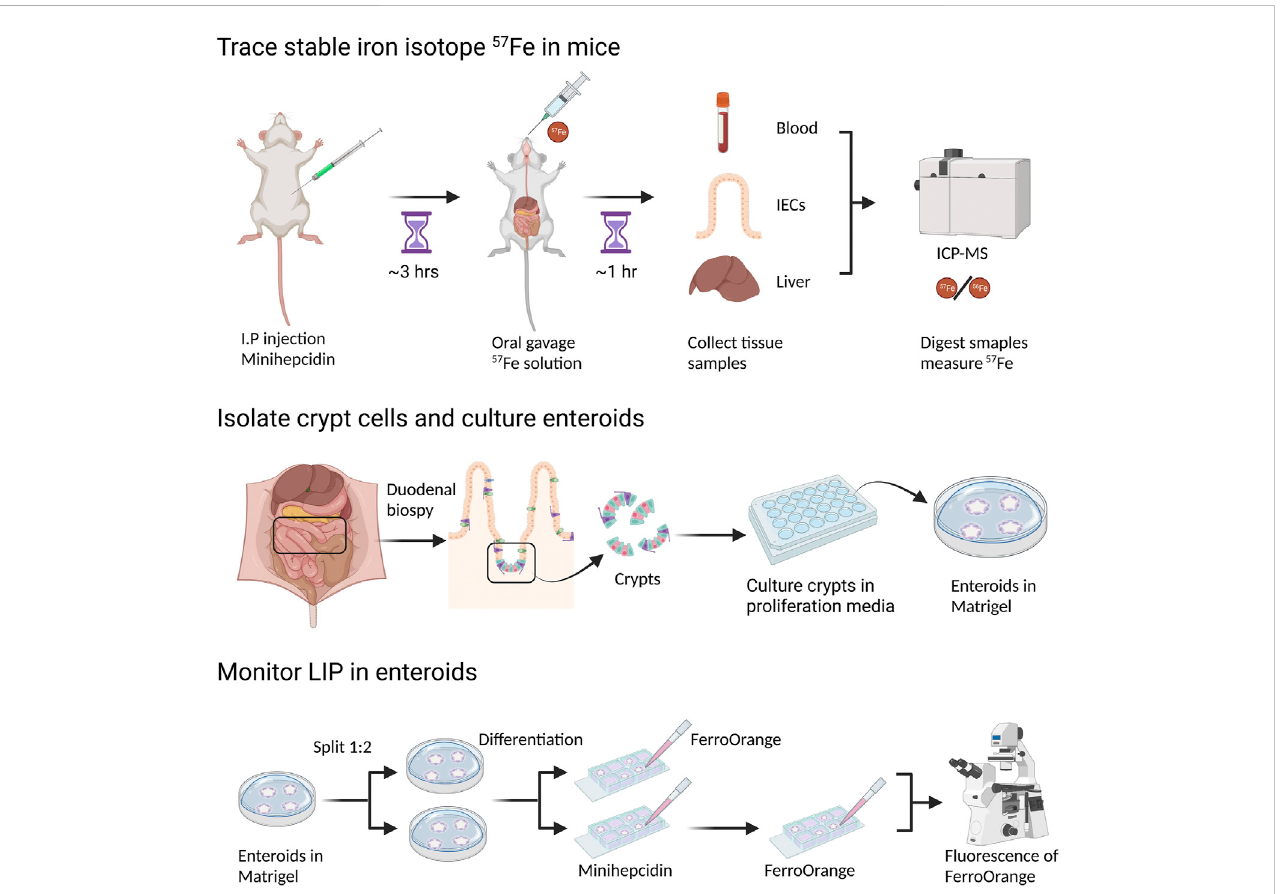
FIGURE 2 Measurement of dietary iron absorption using stable iron isotope 57 Fe. 57 FeSO 4 solution is administrated through oral gavage to mice that are fasted overnight. One hour after 57 Fe administration, mice are sacri fi ced and tissue samples, such as duodenal epithelial cells and liver, are collected. For ICP-MS analysis,samplesneedtobedigestedinconcentratedHNO 3 . 57 FecontentindifferenttissuescanbedeterminedbyICP-MSthoughthedifferenceof 57 Fe/ 56 Fe ratio before and after 57 Fe administration. To block dietary iron absorption through duodenal ferroportin, soluble minihepcidin is injected intraperitoneally into mice several hours before 57 Fe